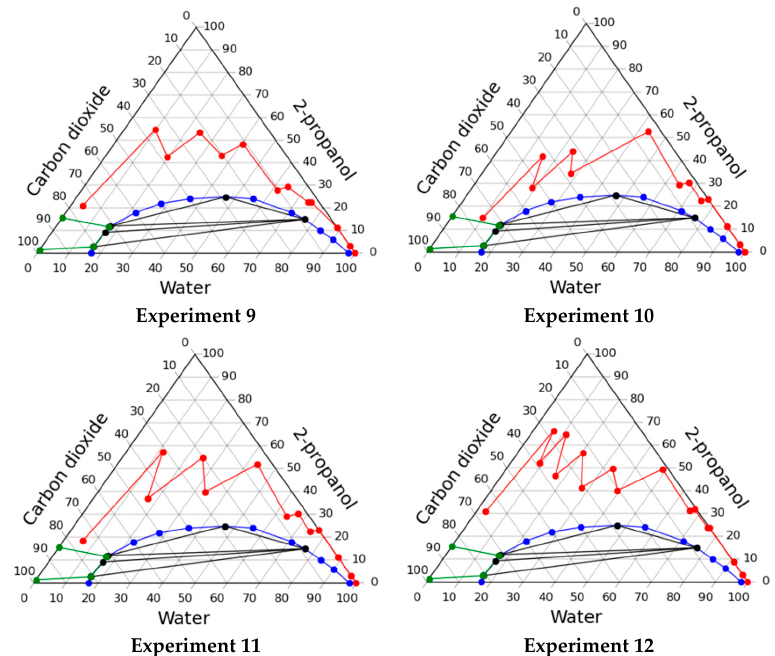
Figure 4. Operating lines of the solvent exchange process through homogeneous region in various experiments. Table 4. Consumption of components and gel shrinkage during the solvent exchange process through homogeneous region.